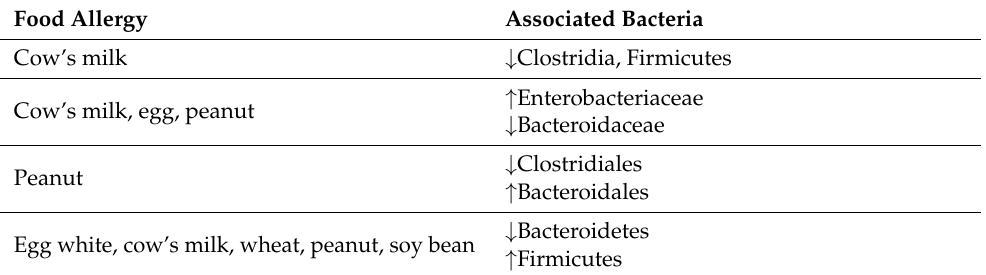
Table 1. Association between the most frequent food allergy and microbiota.